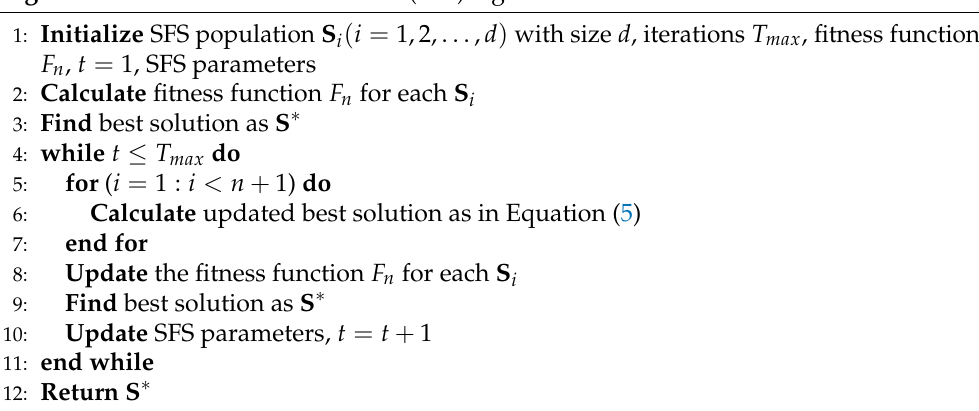
Algorithm 2 Stochastic fractal search (SFS)